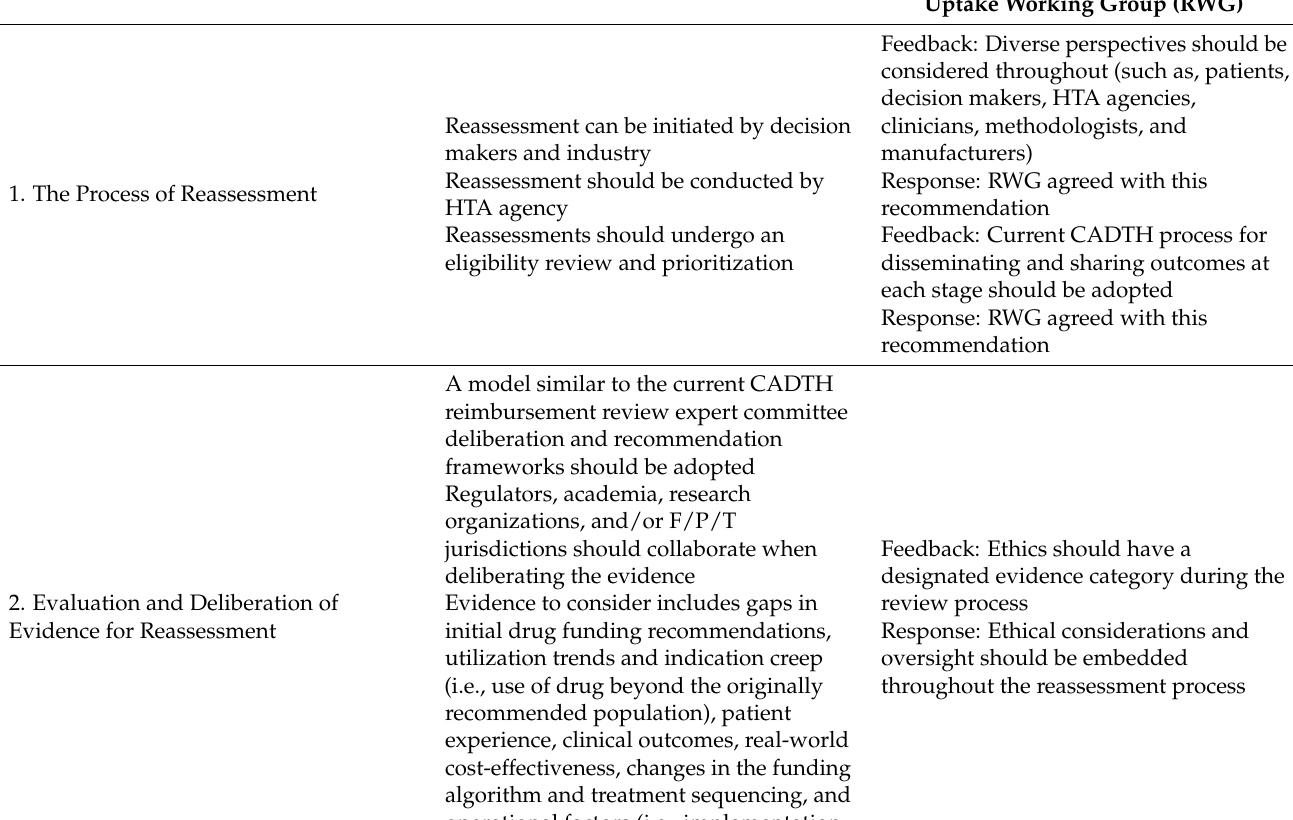
Table 2. Summary of Four Main Considerations when Developing a Reassessment Process.